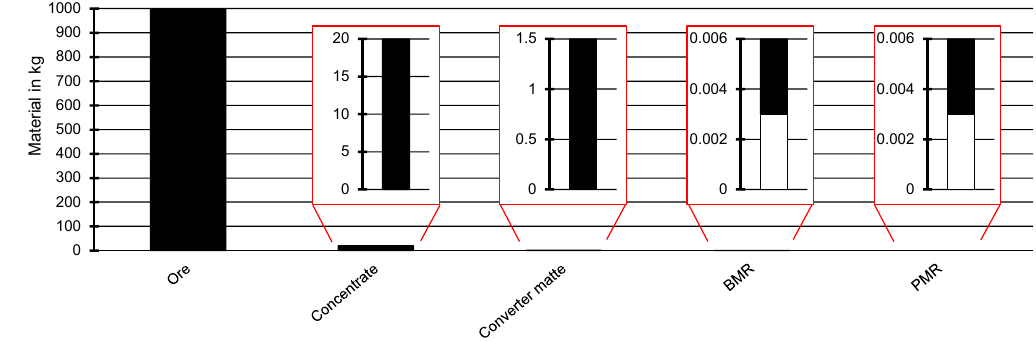
Figure 3. Processed material at each production step, assuming PGE contents of 0.0003%, 0.015%, 0.2%, 50% and 99.95% of ore, concentrate, converter matte, base metal refinery (BMR) leach residue and final precious metal refinery (PMR) product, respectively. Detailed views of each product stream framed in red.